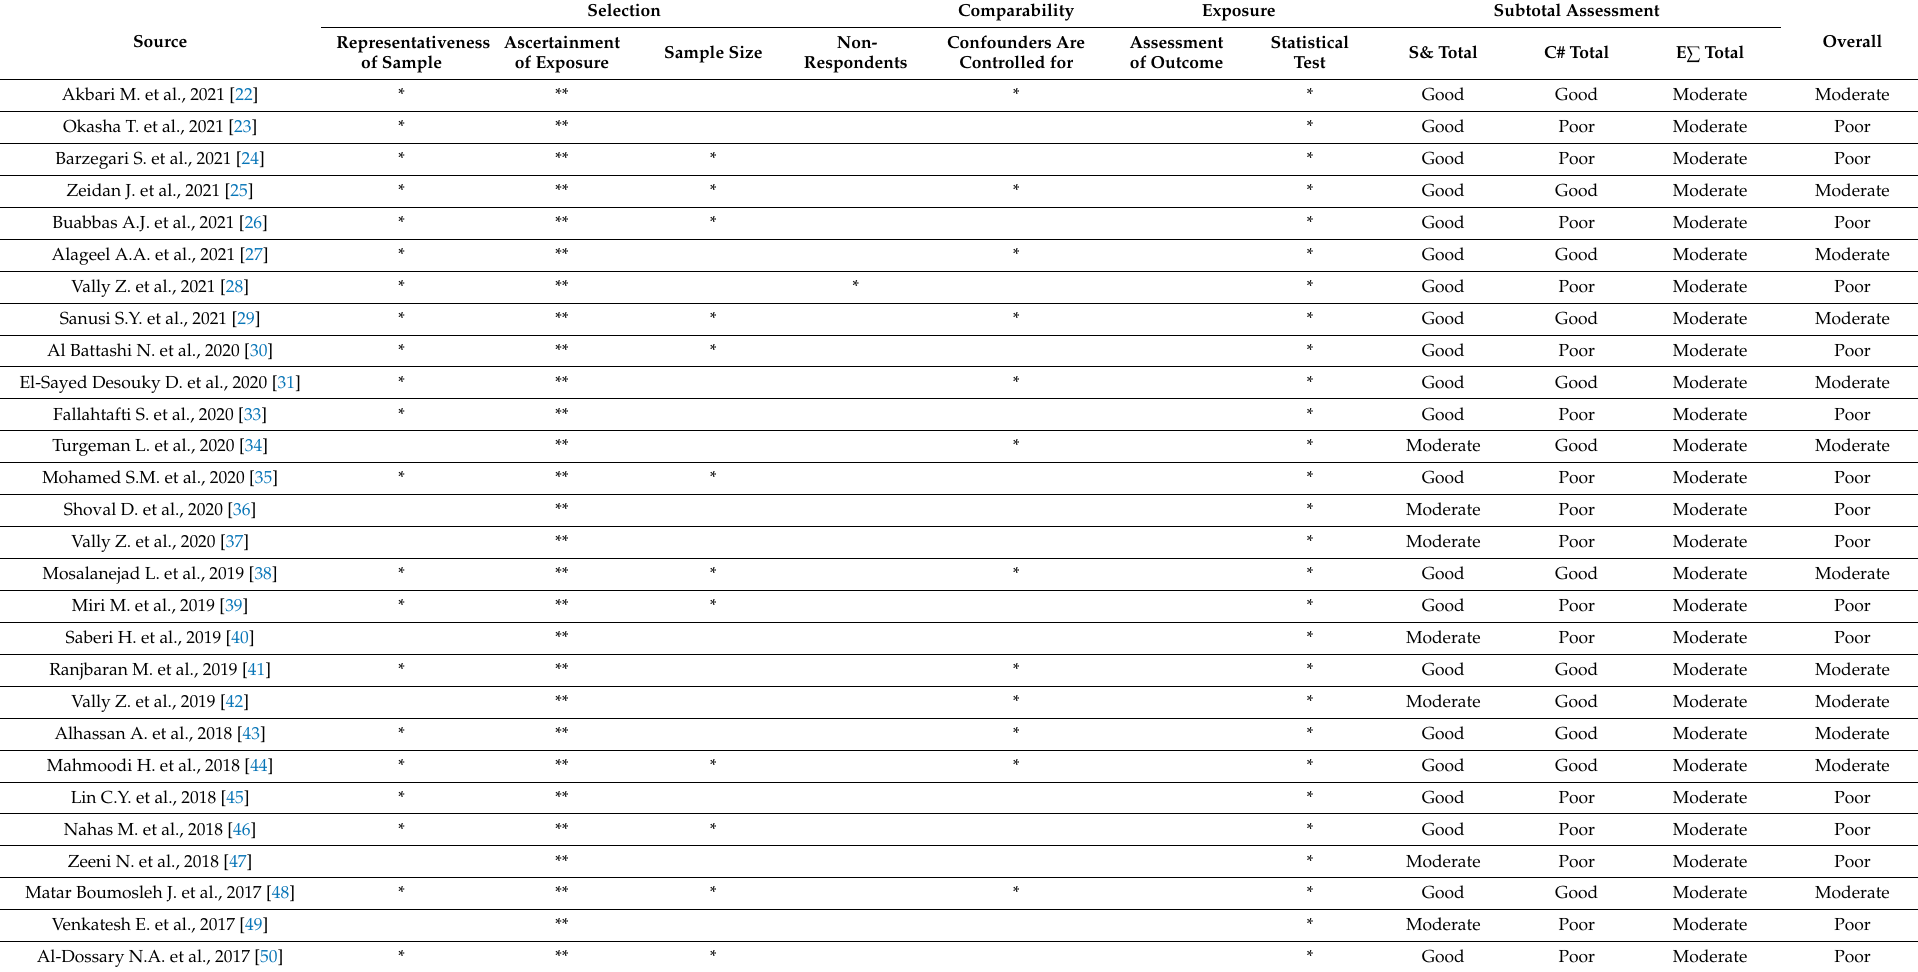
Table 2. Quality assessment of included cross-sectional studies using the Newcastle-Ottawa